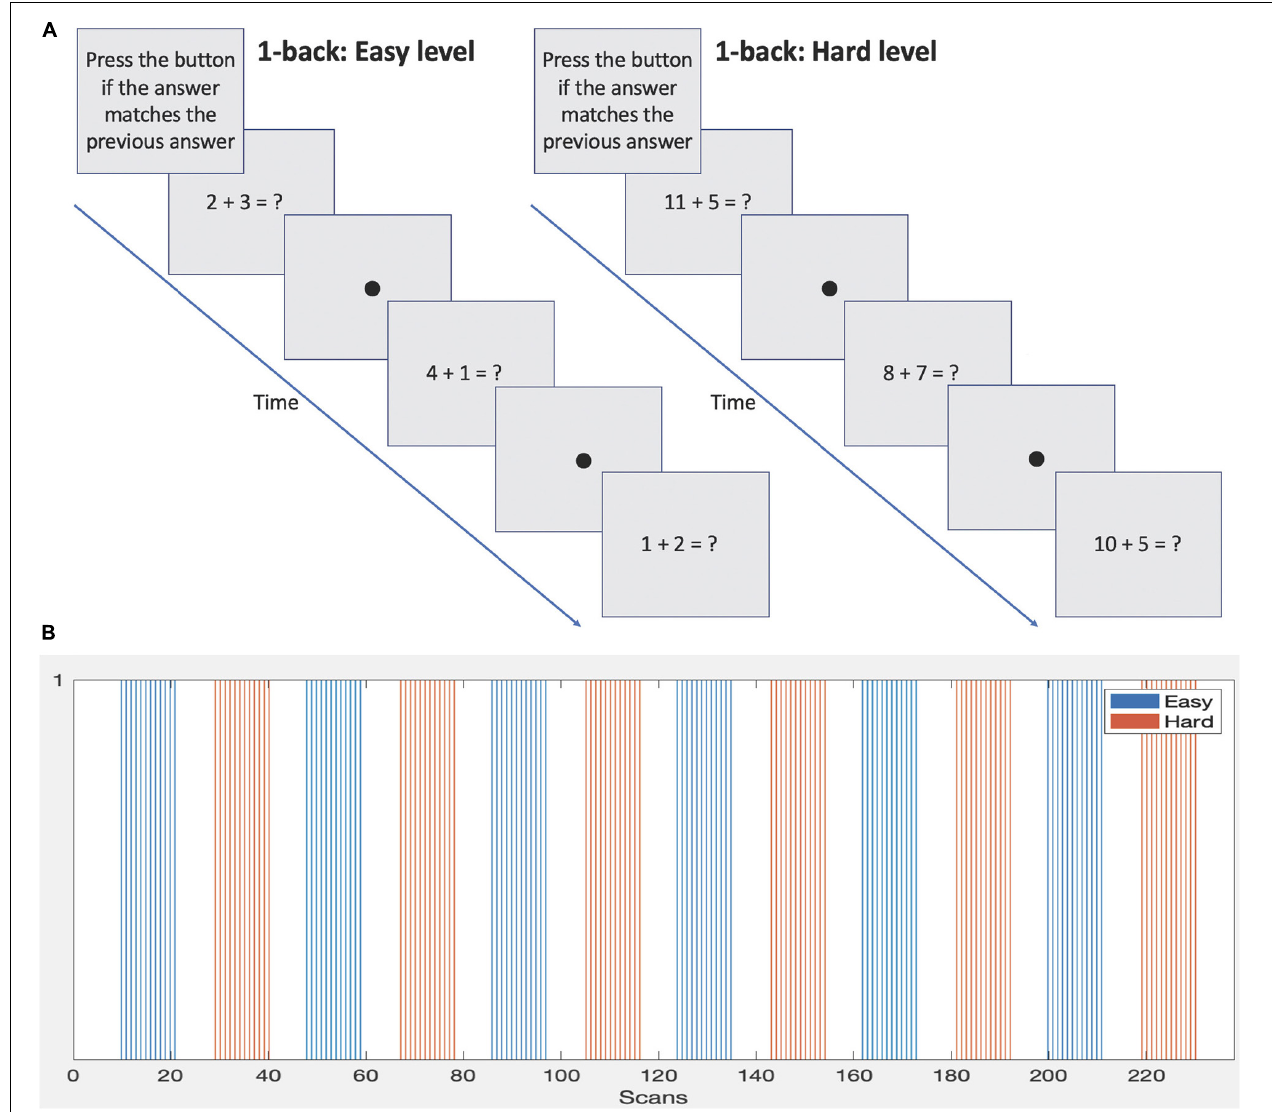
FIGURE 1 | (A) Sample 1-back protocols demonstrating the two difficulty levels. (B) Block design and timings of each difficulty level.